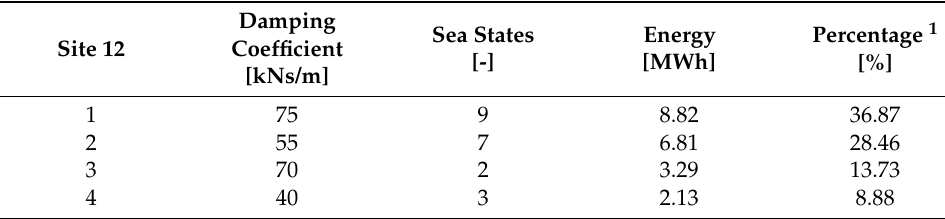
Table 6. Optimal damping coefficient contributed the most to total annual